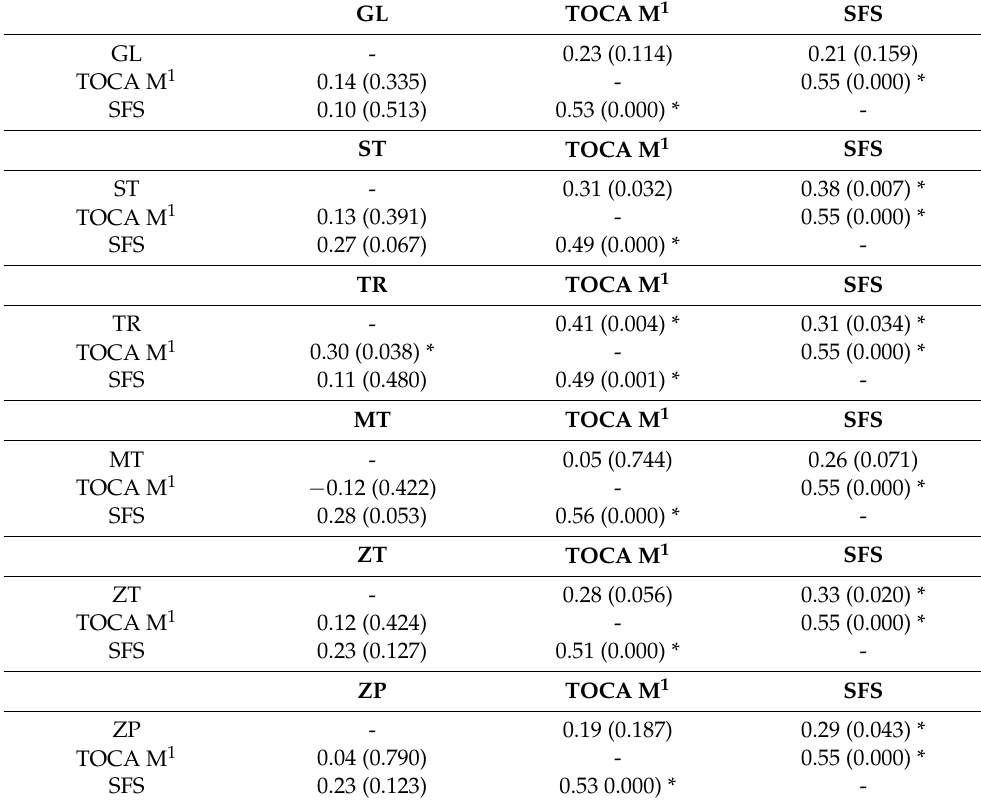
Table 8. Results of Spearman’s rank correlation analysis (top) and partial rank correlation analysis (bottom) obtained for examined traits including the TOCA of M 1 s—male cranial